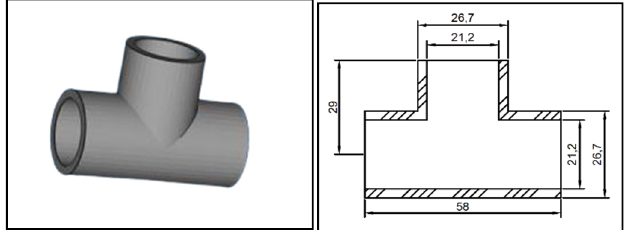
Figure 4. CAD drawing of the part selected for the case study: Pipe tee joint ¾’’ (dimensions in mm).